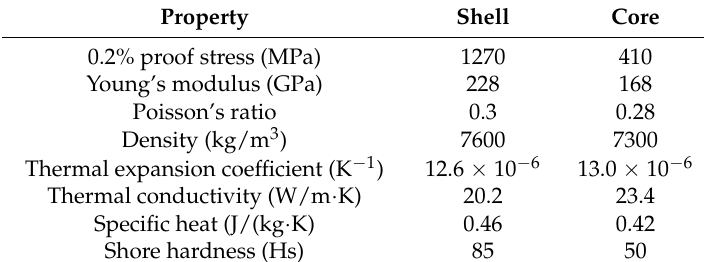
Table 1. Mechanical properties of the shell and core at room temperature.